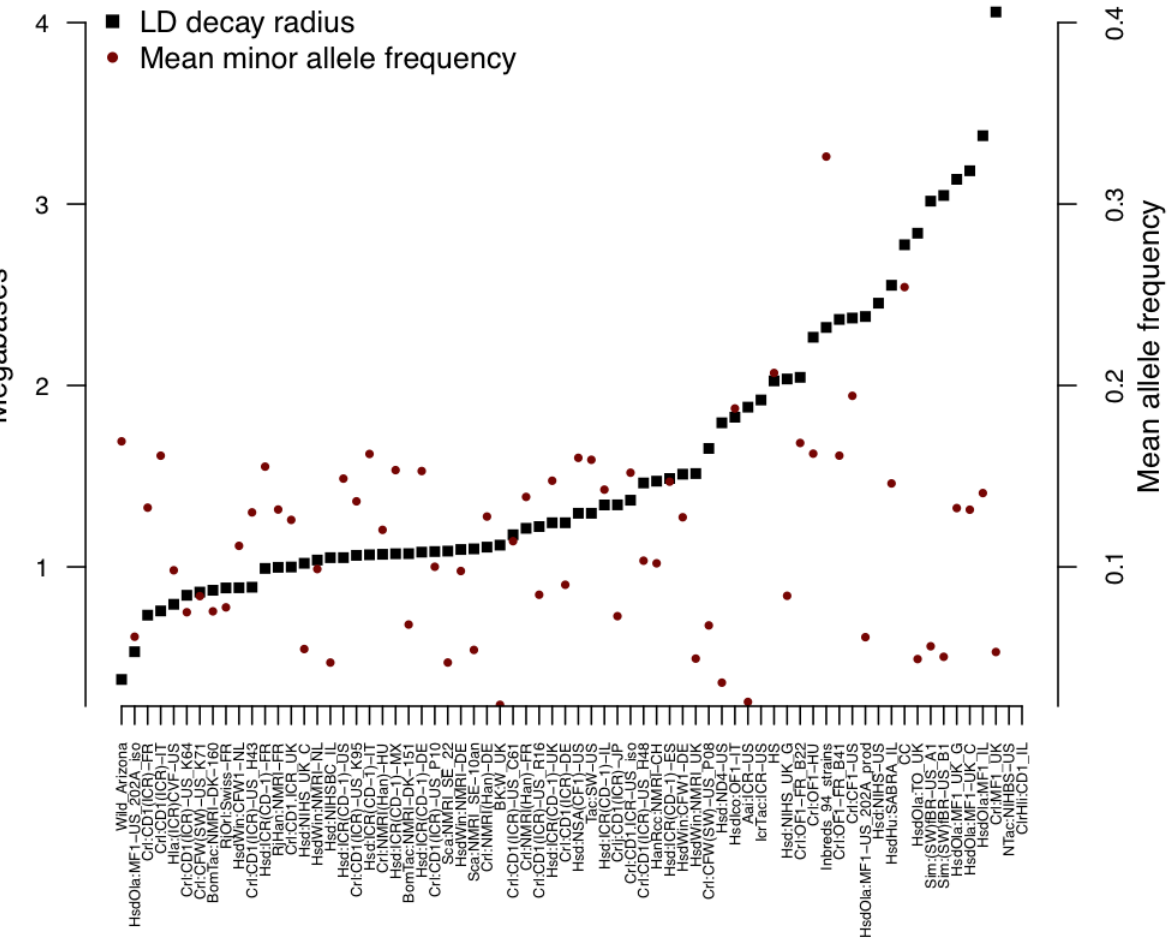
Figure 2. Linkage disequilibrium decay radius (black) and minor allele frequencies (red) in outbred mice. The scale of the vertical axis is megabases for the decay radius and ten times the value of the mean allele frequency (so a value of 2 is 0.2).